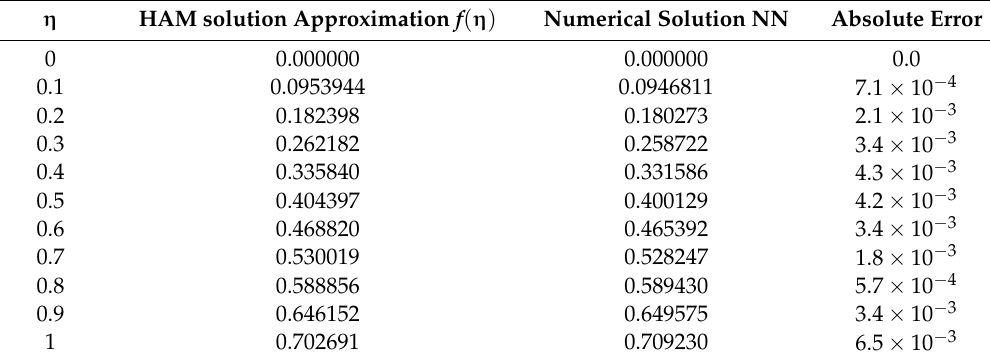
Table 1. Comparison between HAM and numerical solutions for velocity field f ( η ) when (cid:125) = − 0.28,